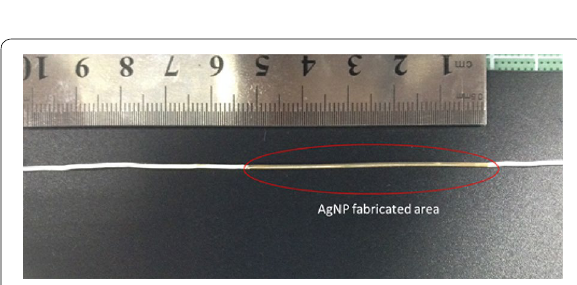
Fig. 10 Photographic image of an in situ AgNP fabricated catheter for use in a pre-clinical